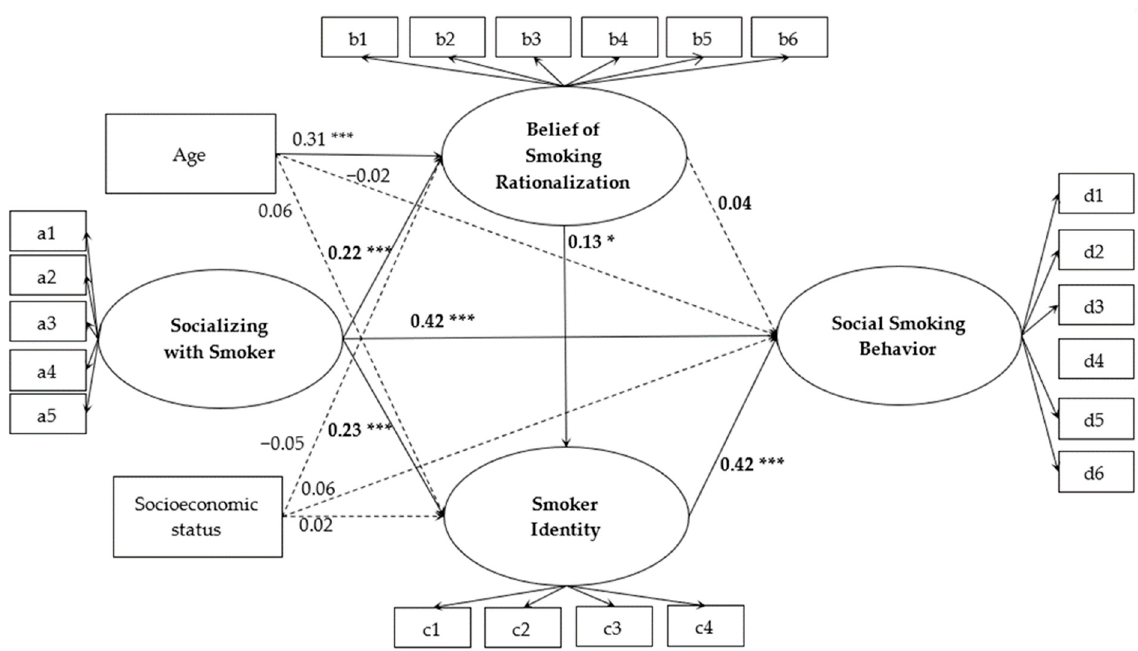
Figure 2. The finalized structural model (factor loadings are standardized, N = 696). Note: * p < 0.05, *** p < 0.001.